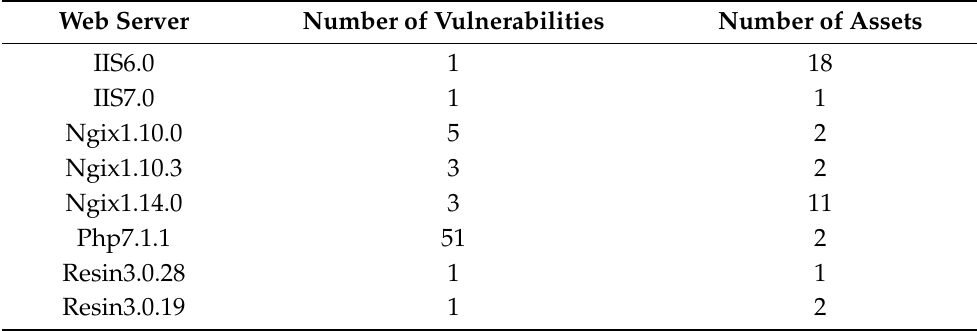
Table 16. Number of vulnerabilities belonging to the Web servers and the number of these Web servers.